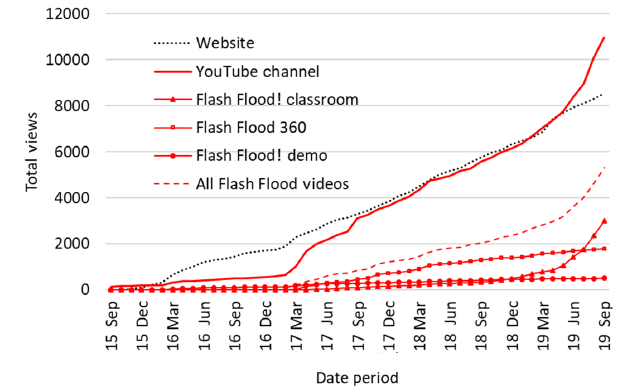
Figure 9. Cumulative views for SeriousGeoGames online content, including the SeriousGeoGames website and YouTube channel, and cumulative views for the videos related to Flash Flood! on the SeriousGeoGames YouTube